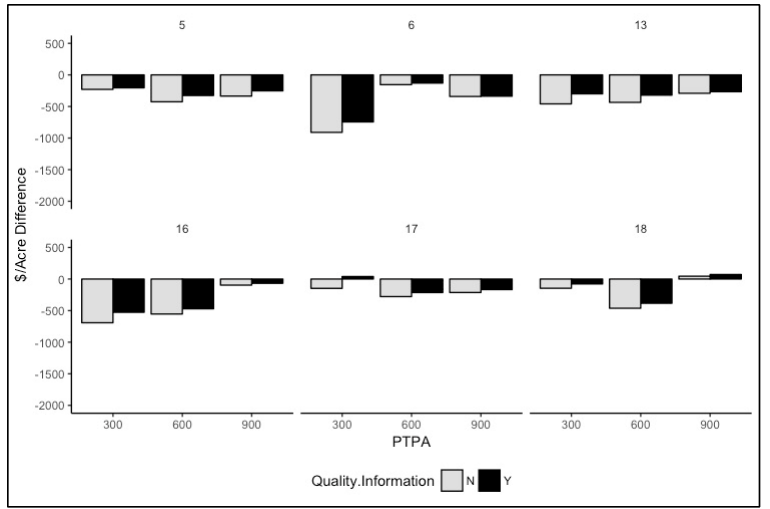
Figure 7. Difference in operational management and intensive management standing timber value (U.S. $/hectare) at age 16 for each installation (installation number indicated above bars). Intensive management dollar value subtracted from operational for each planting density. Quality information includes the use of the TQI scores and product-defining defect heights. Negative values indicate a per hectare value greater for the intensive management regime than the complimentary operational management regime for the given planting density. “Y” = Yes, “N” = No. By age 30, 28 plots subject to intensive management exhibited higher per hectare values than their operational counterparts (Figure 8).